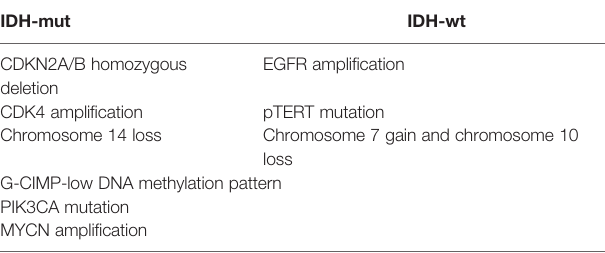
TABLE 1 | Genetic aberrations conferring an aggressive behavior to grade 2 astrocytomas. Molecular alterations with a poor prognostic role in grade 2 astrocytomas